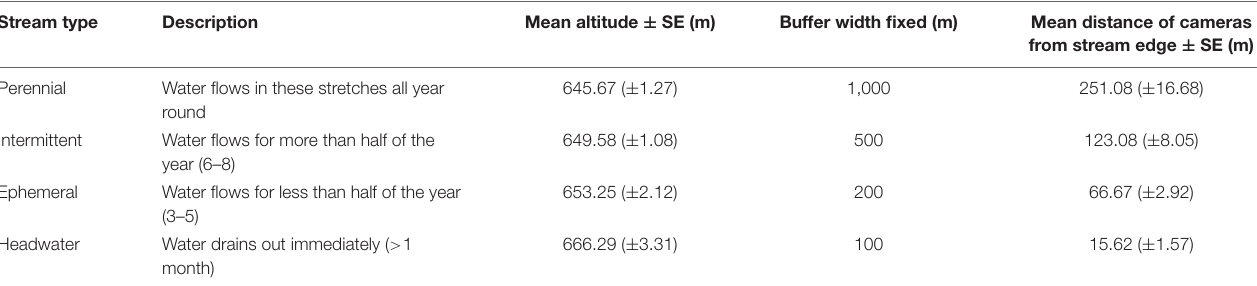
FIGURE 1 | Map of study area detailing the field survey design and the camera trap locations. In each of three sections of the river we sampled four kinds of stream types: perennial, intermittent, ephemeral and headwater streams. TABLE 1 | Description of riparian habitat complexes/habitat types selected for the study and the rationale/basis for selecting the habitat